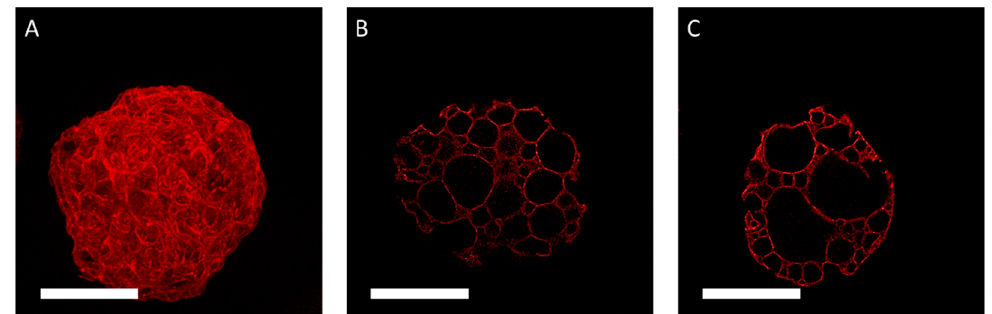
Figure 4. Confocal microscopy analysis of the prototype BR44 MC stained with the fluorescent CF633 dye. ( A ). 2D convolution. ( B , C ). Microphotographs of two different sections. Magnification 400×, scale bar 100 µm.